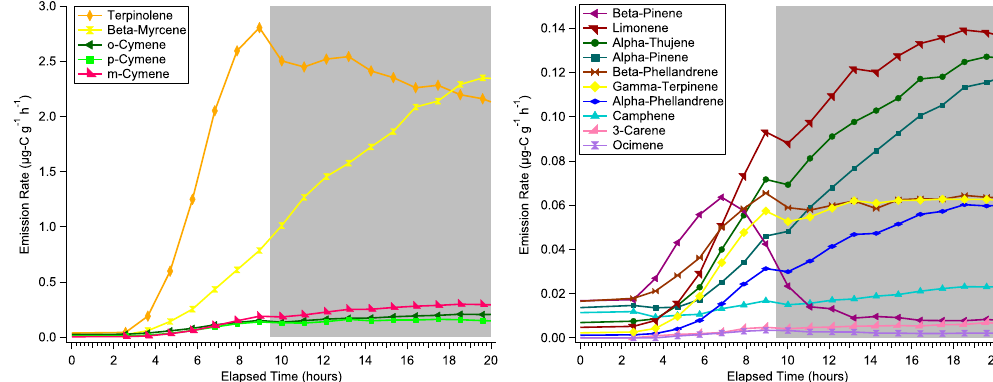
Figure 7. Time series of monoterpene emission rates from Thuja plicata . The x axis shows the elapsed time since treatment application in hours. Alternating shaded and unshaded regions demonstrate when the light above the plant enclosure was turned off and on, respectively.